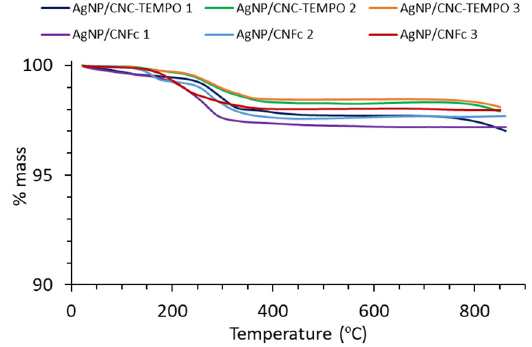
Figure 3. Thermogravimetric (TGA) measurements of Ag NP/NC composites.